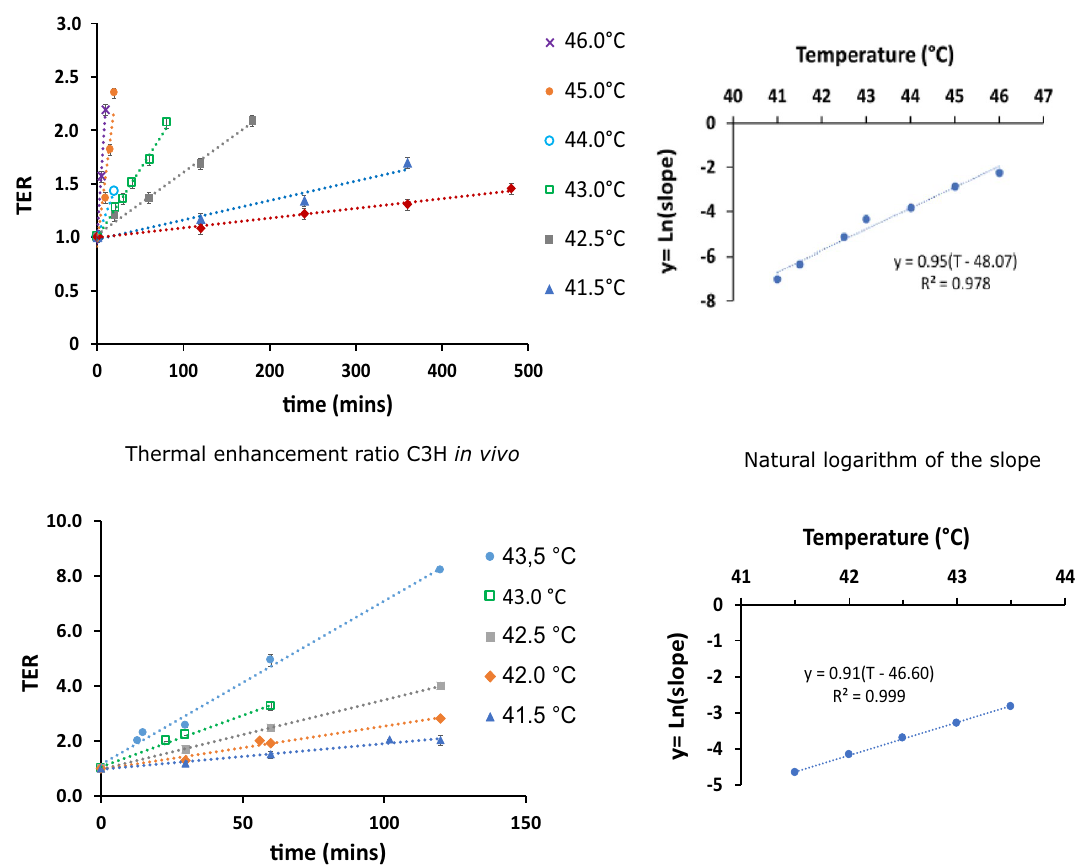
Figure 2. ( a ) and ( c ) show the linear dependency of the thermal enhancement ratio (TER) on time of exposure for CHO cells in vitro and C3H mammary carcinoma cells in mice tumours in vivo , respectively. The slope of the linear fitting clearly depends on the temperature of the hyperthermia treatment, and the natural logarithm of the slope was plotted as a function of temperature for both datasets in ( b ) and ( d ). The linear trend lines show the exponential behaviour of the temperature dependent rate k ( T ) according to Eq. (6). The data for CHO cells ( a , b ) and C3H mammary carcinoma ( c , d ) was extracted from 58 and 60 , respectively.